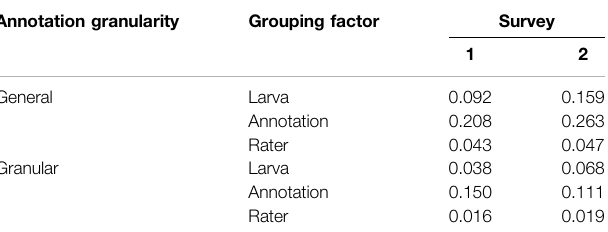
TABLE 3 | Intraclass correlation repeatability